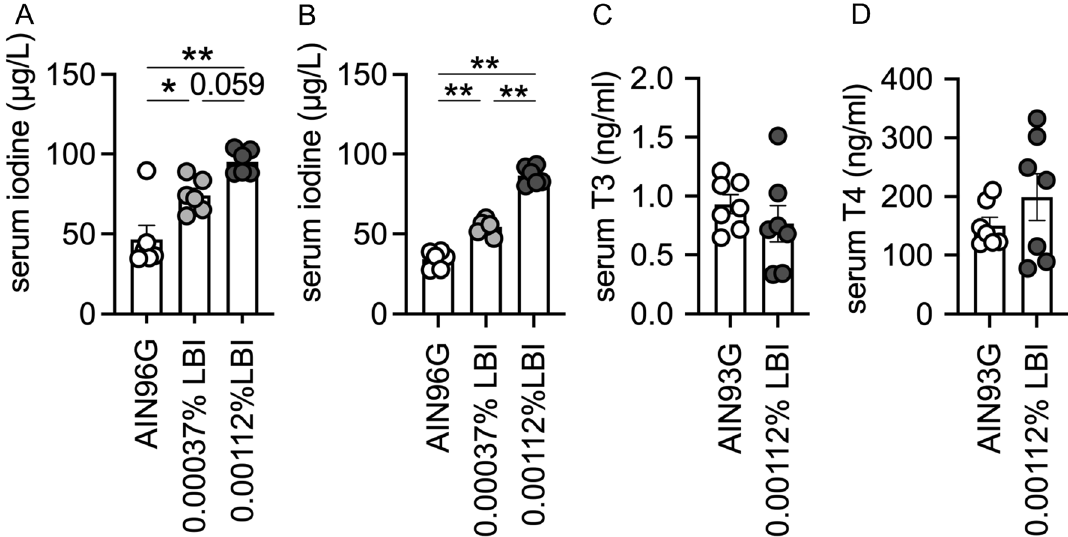
Figure 2. LBI increases serum iodine levels in mice. ( A , B ) The concentration of serum iodine was measured on days 7 ( A ) or 21 ( B ) of LBI feeding. The data were pooled from two independent experiments and shown as the means ± SEM ( n = 6 for each group). ( C , D ) The concentrations of triiodothyronine (T3) ( C ) and thyroxine (T4) ( D ) in serum were measured on day 7 of LBI feeding. Data are pooled from two independent experiments and shown as the means ± SEM ( n = 7 for each group). One-way ANOVA test with Tukey’s multiple comparisons test ( A , B ). Student’s t -test ( C ). Welch’s t -test ( D ). n.s., not significant; * p < 0.05, ** p <